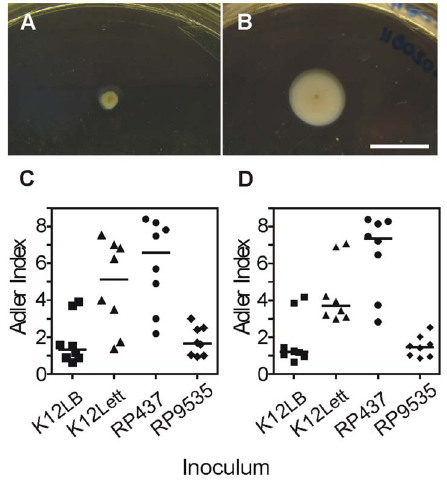
Figure 6. Chemotactic response of plant-adapted Escherichia coli . (A–B) Chemotactic response onto TB medium of (A) non-adapted or (B) plant-adapted bacteria. The bar in (A–B) represents 1 cm. (C–D) Chemotactic response towards (C) lettuce leaf blade or (D) lettuce-leaf main vein extracts. K12LB, non-adapted E. coli strain MG1655; K12, plant-adapted E. coli strain MG1655; RP437, non-adapted E. coli strain RP437 (genomic background of reference for chemotactic analysis); and RP9535, non-adapted E. coli strain RP9535 ( D cheA1643 mutation in a RP437 genomic background). Strains RP437 and RP9535 were used as control of chemotactic and non-chemotactic E. coli K12 bacteria. Results